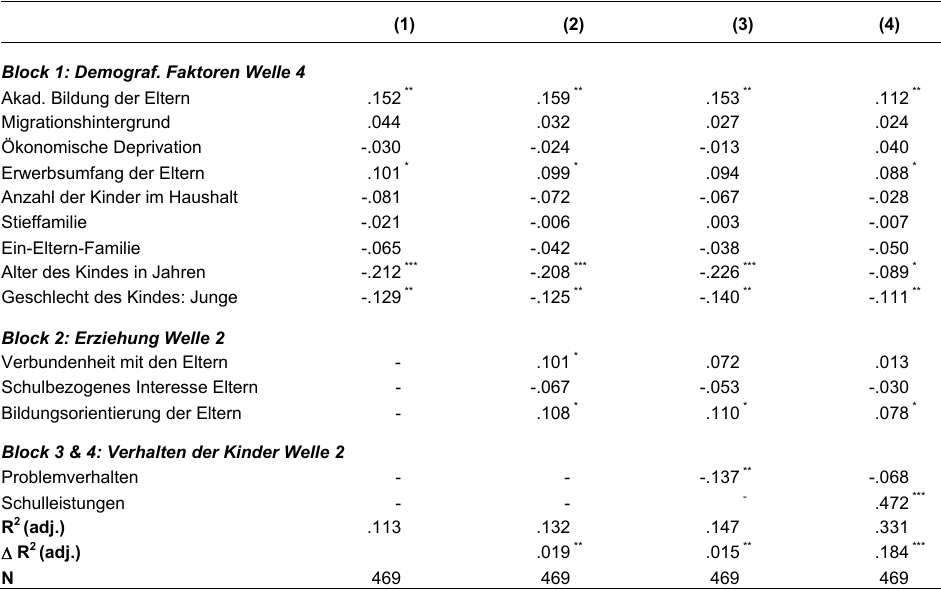
Tabelle 1 : Effekte auf schulische Leistungen (Welle 4):